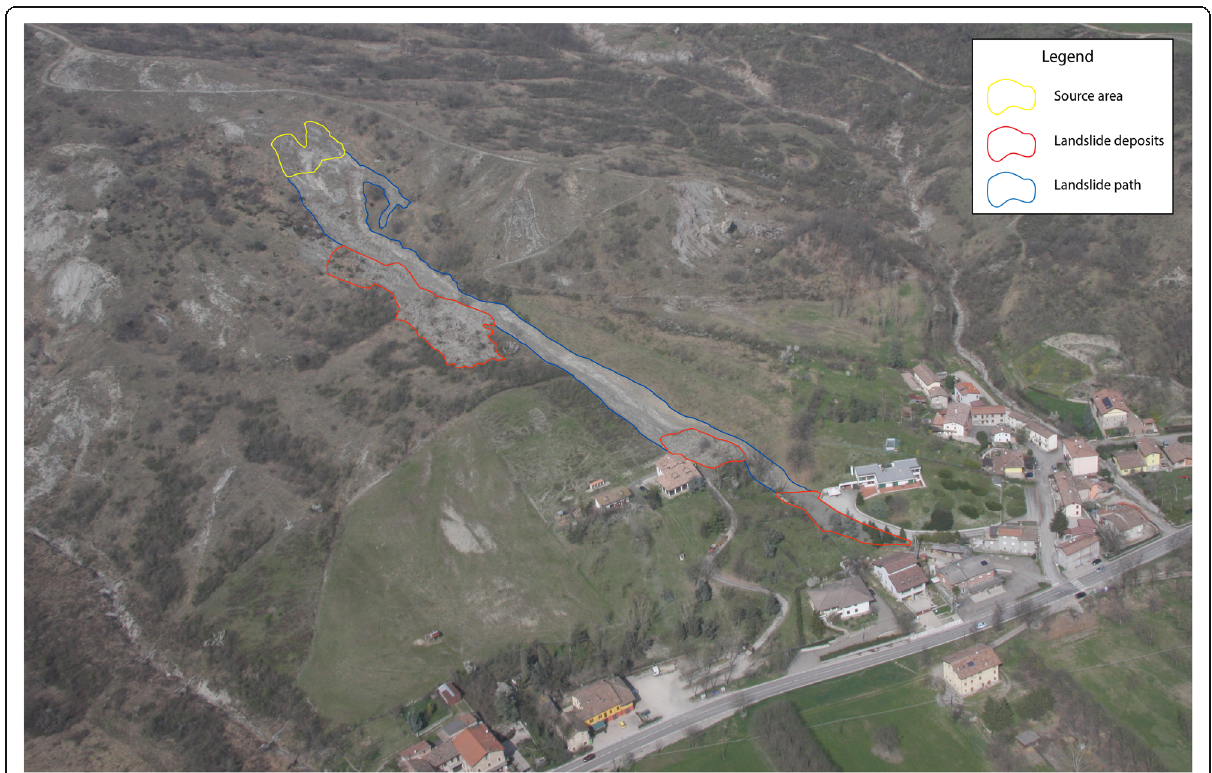
Fig. 2 Aerial photograph of the Gessi-Mazzalasino landslide (photo by G.